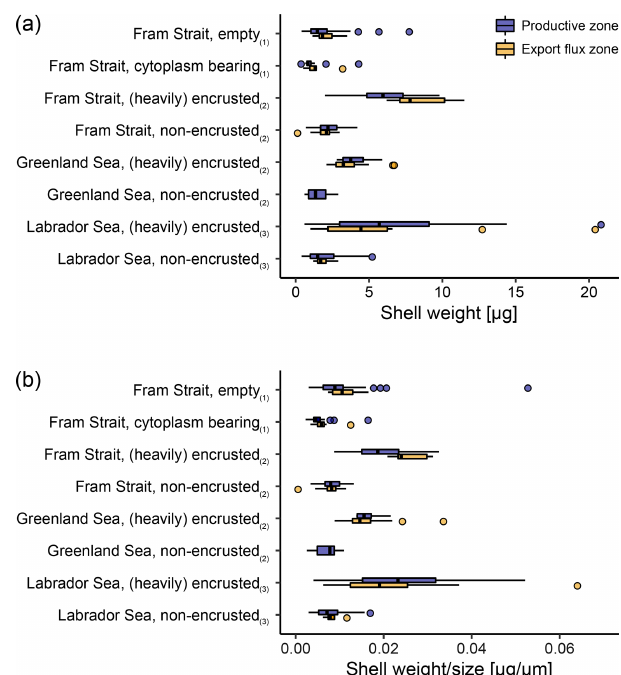
Figure 6. Overview of (a) average shell weight and (b) calcifi- cation intensity (weight / size) from shells with a different status. In this study (1), differentiation was made between cytoplasm- bearing and empty shells on shells ≥ 63µm, while Kohfeld (1998; shells ≥ 150µm; (2)) and Stangeew (2001; shells ≥ 63µm; (3)) dis- tinguished between (heavily) encrusted and non-encrusted shells. Besides, different sampling regions are distinguished. Blue boxes show the parameter within the productive zone of each station and orange boxes the values from samples taken below the estimated productive zone of each station. The boxes and bars represent the interquartile range as explained in the caption of Fig.